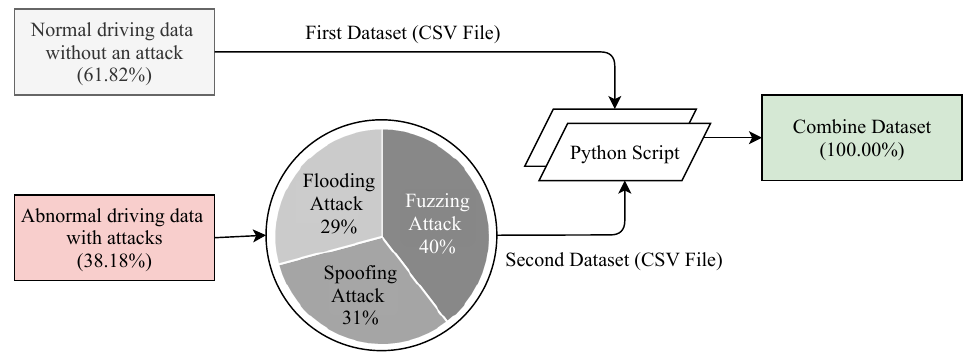
Figure 7. Statistics of the